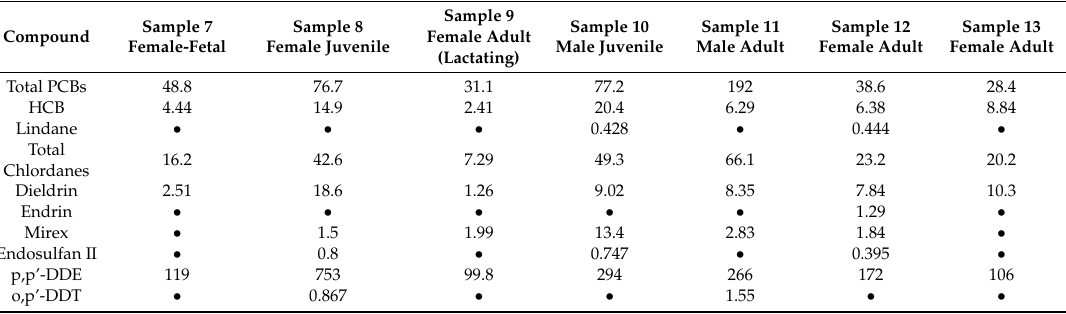
Table 5. Organochlorines (ppb, ng / g wet weight) in bat carcasses from Shell Mountain Bat Cave. Dots represent non-reported numerical values that were either below minimum detection level, subject to interference, or not